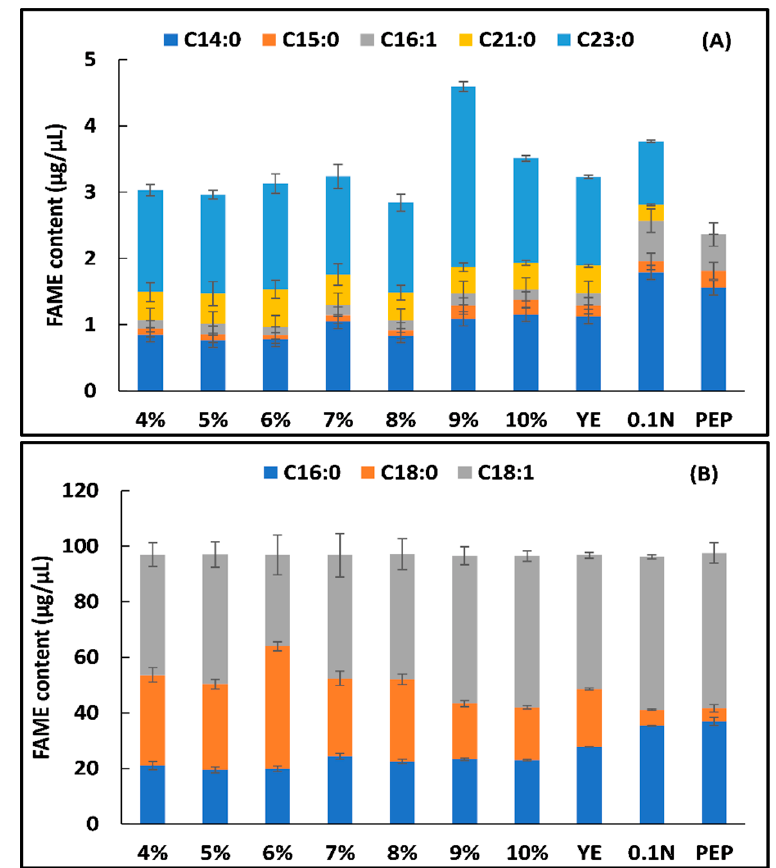
Figure 4. Fatty acid profile of R. toruloides ( A ) C14:0, C15:0, C16:1, C21:0 and C23:0 ( B ) C16:0, C18:0 and C18:1 quantified using gas chromatography-mass spectrometry (GC-MS) at different carbon and nitrogen sources ( p < 0.05). YE represents yeast extract, 0.1 N represents 0.12% ammonium sulfate, PEP represents peptone as nitrogen source. The YNB medium with glucose 3–10% contains 0.5% ammonium sulfate and all other samples contain 50 g/L (5%) glucose.